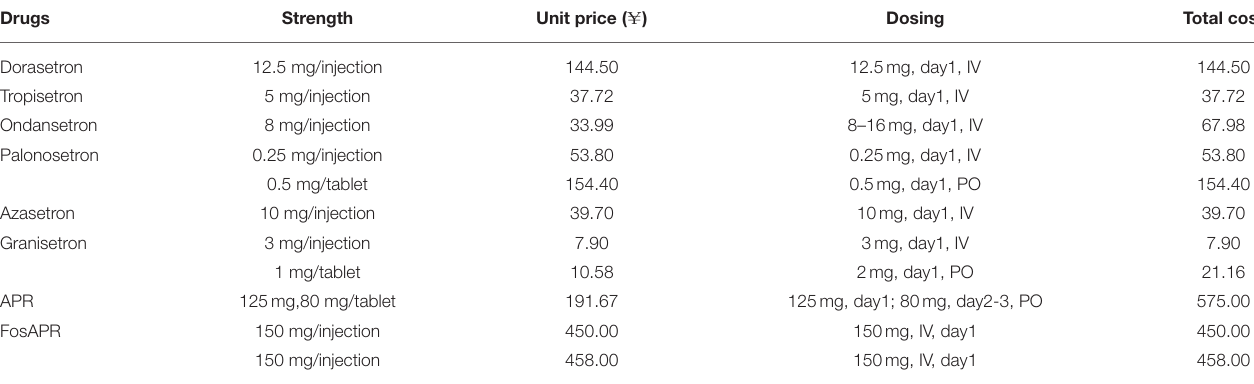
TABLE 7 | Daily administration schemes and prices of a single course for prevention of